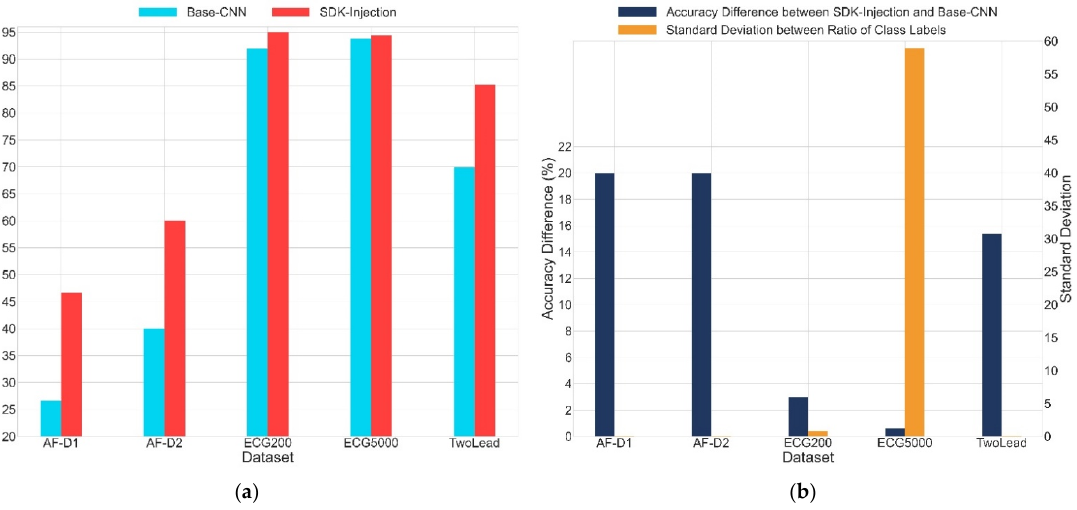
Figure 6. Performance evaluation when the SDK-Injection method is applied to each dataset: ( a ) test accuracy when SDK-Injection is applied to each dataset (red) and test accuracy of Base-CNN for each dataset (sky blue); ( b ) standard deviations of ratio of class labels (gold) for each dataset and difference in accuracy between SDK-Injection method and Base-CNN (dark blue). Ratio of class labels is shown in Table 1. The datasets with standard deviations close to 0 are balanced datasets. Table 2. Performance evaluation of Base-CNN and SDK-Injection. Table 3. Performance evaluation of Base-CNN and SDK-Injection per